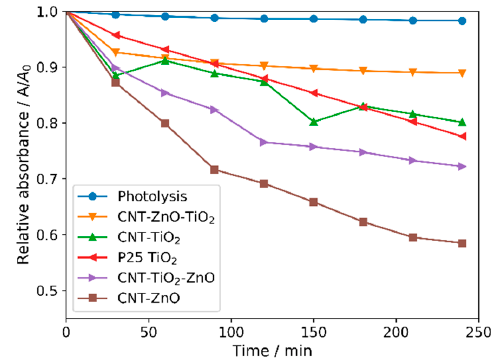
Table 4. The measurements of the specific surface areas of the samples.